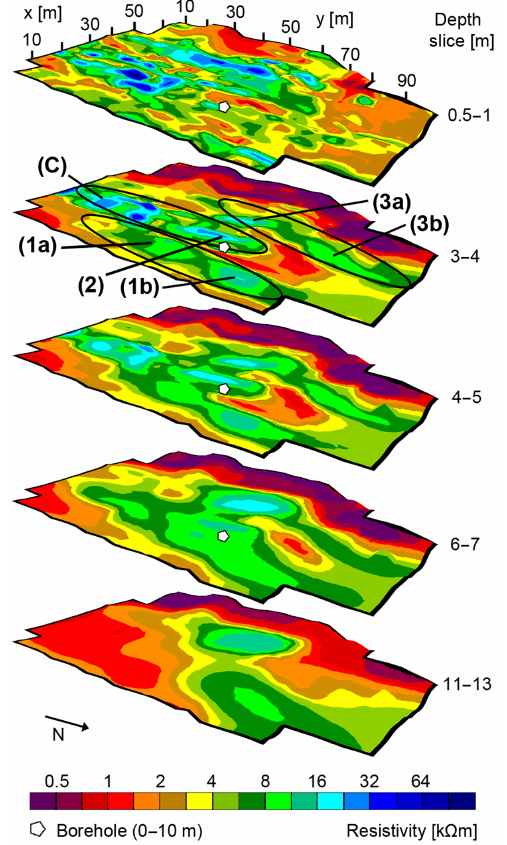
Figure 6. Selected depth slices of the quasi-3-D ERI model for Uertsch_01. Numbers refer to structures described in the